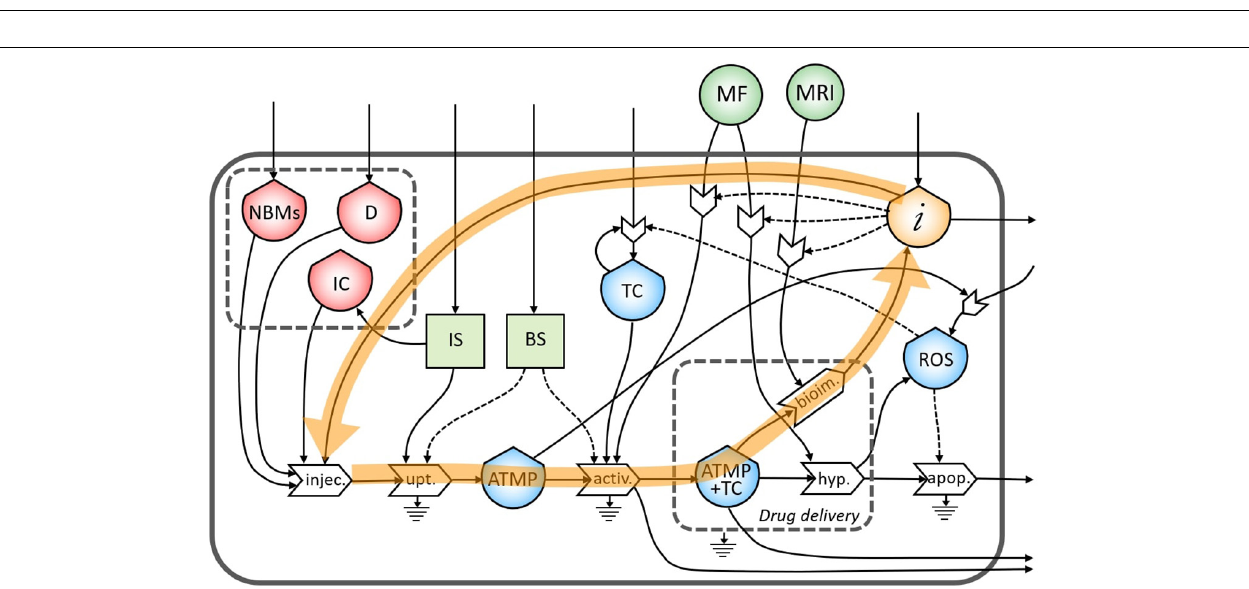
FIGURE 5 | Representation of the feedback loop of the flow of information from the bioimaging to the injection